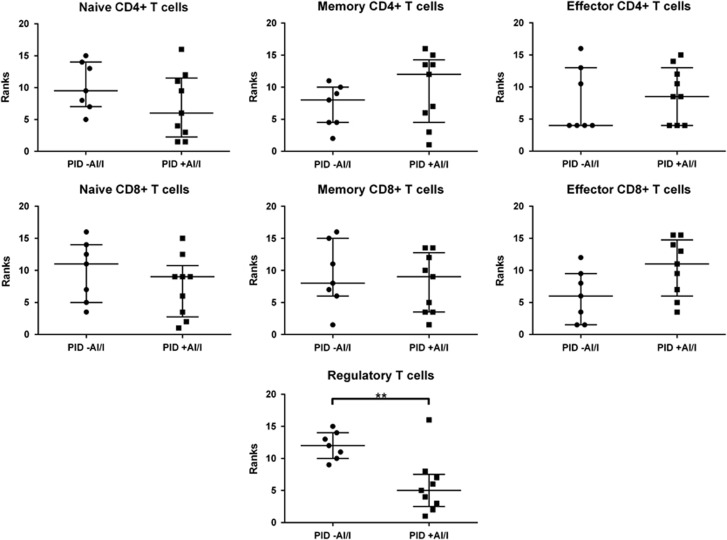
T-cell subgroups compared between the groups, PID without AI/I (PID −AI/I) and PID with AI/I (PID +AI/I) (median and interquartile range). Tregs were significantly reduced in PID +AI/I compared with PID −AI/I (P=0.0079). n=2. *P<0.01.